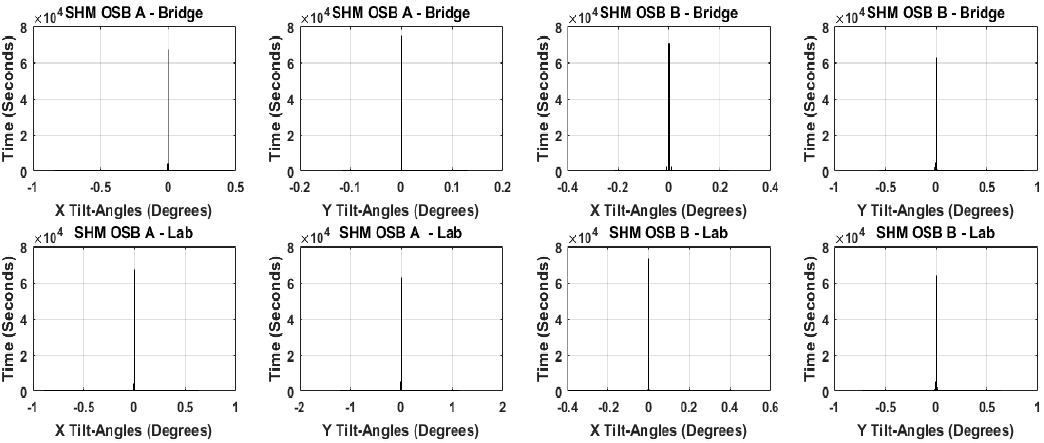
Figure 19. Histogram of data gathered at two unique geolocations in five calendar months (80,000 samples).